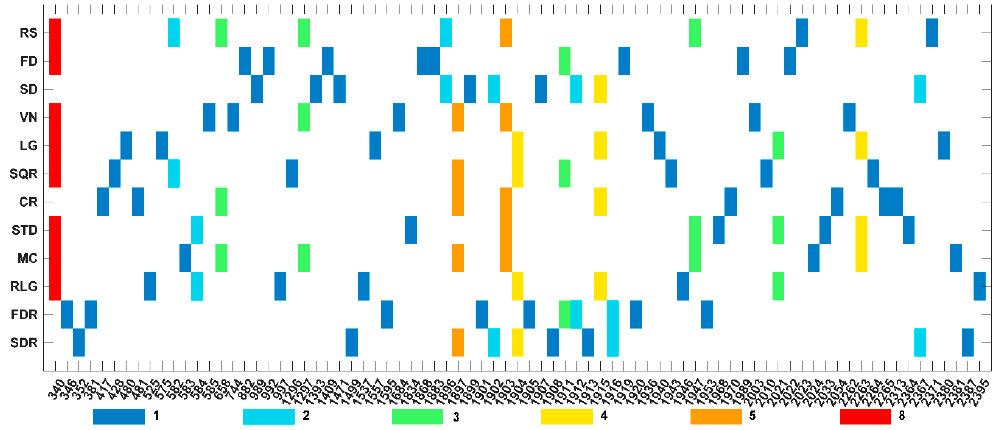
Figure 10. Concentrated map of selected bands of the different spectral forms. The horizontal axis represents the wavelength of the selected band, and the vertical axis represents the 12 spectral forms. The different colors indicate the number of times each wavelength was selected. From left to right, the wavelength selected for each form can be known. From top to bottom, which form is selected for each wavelength can be seen.